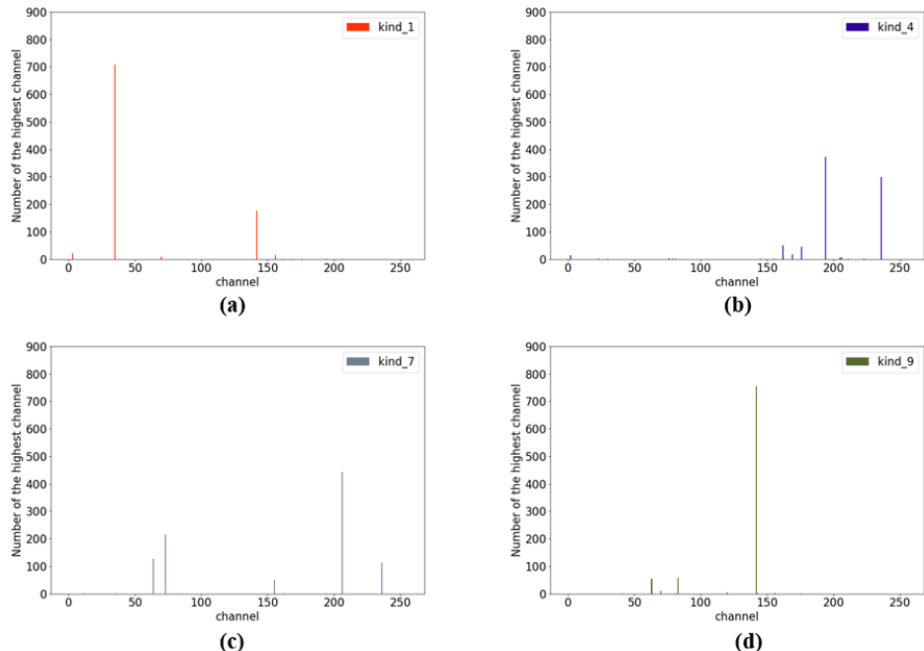
Figure 2. ( a – d ) The number of channels with the highest average activation value for 10,000 images in the trained ResNet-56 model’s last layer for the images of four categories. We randomly choose four categories in CIFAR10. The x -axis shows the specific channel, and the y -axis measures the number of images in the corresponding channel with the highest activation value. The channels with the highest activation value are different for different categories of images, but there are one or two fixed channels with the highest activation values for the successfully classified images in the same category.